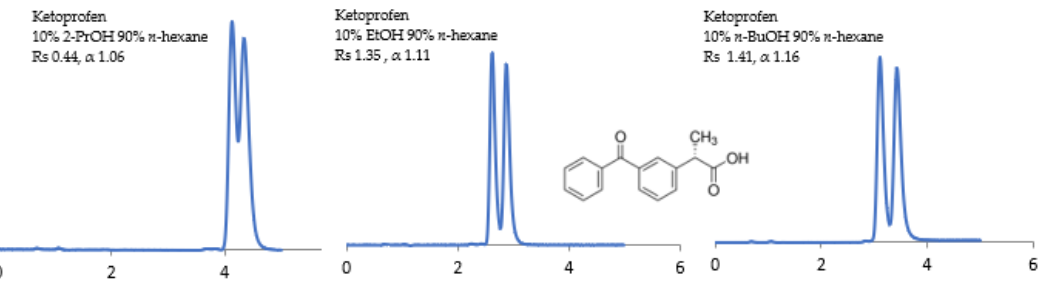
Figure 5. Effect of different alcohol modifiers with n -hexane on resolution (Rs) and separation factor ( α ) of ketoprofen. Ketoprofen expressed an increasingly enhanced Rs and α in the order of 2-propanol (2-PrOH) to ethanol (EtOH) to n -butanol ( n -BuOH).